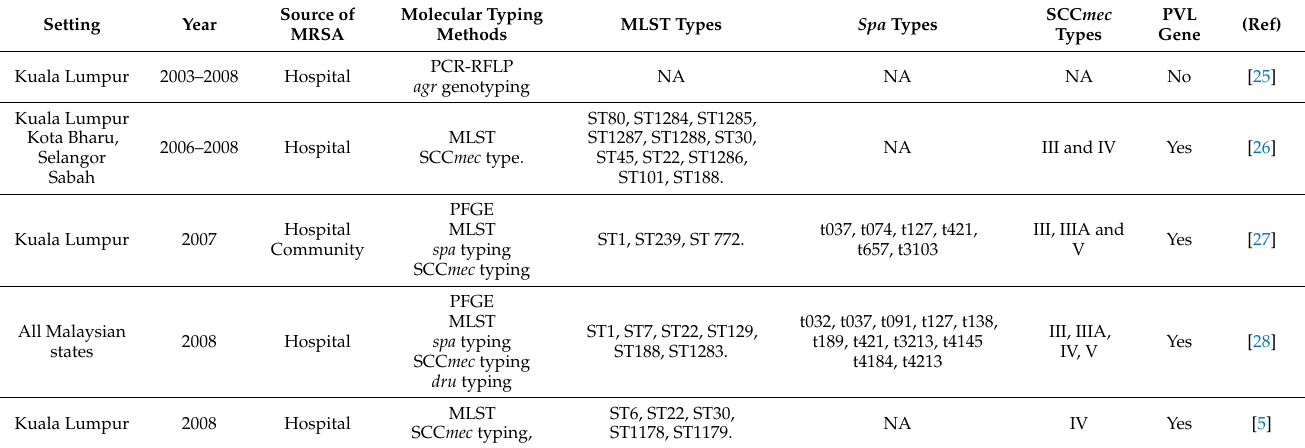
Table 1. Clonal characteristics of methicillin-resistant Staphylococcus aureus isolates in Malaysia